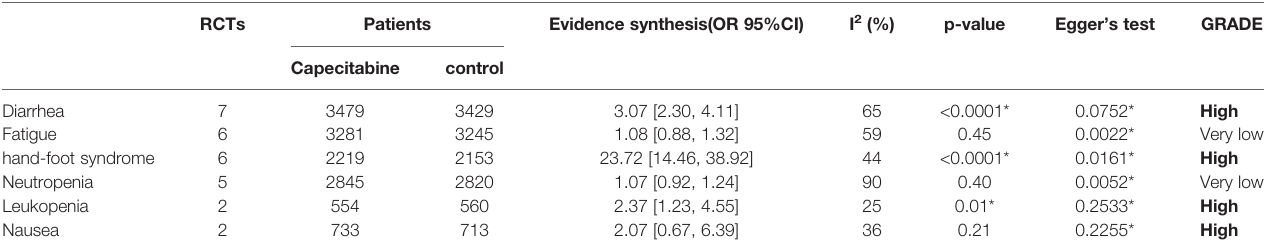
TABLE 1 | The result of adverse